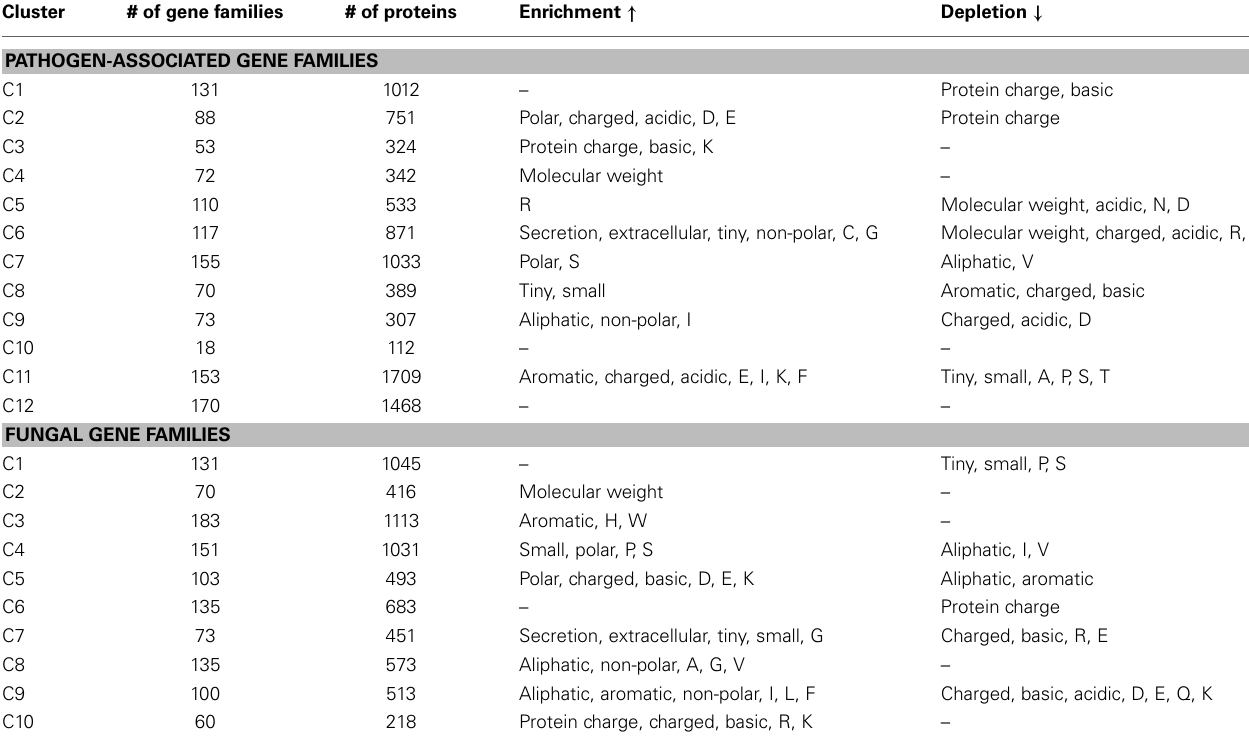
Table 1 | Properties for the clusters of pathogen-associated and fungal gene families are shown.